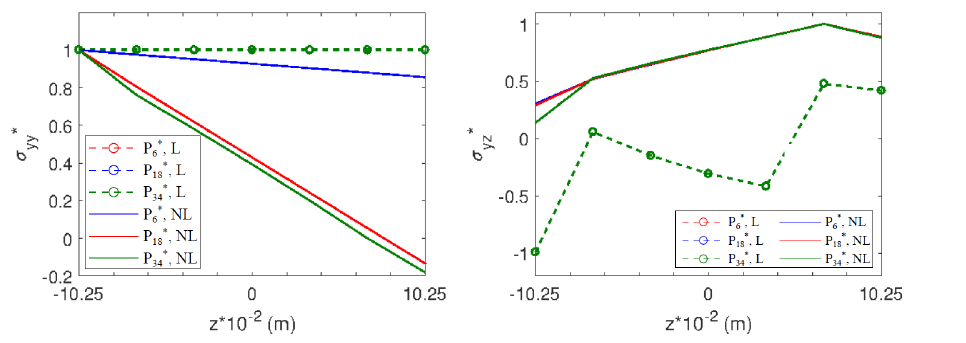
= − 3.3 − 4 , P ∗ = − 2.9 − 3 , 6 18 = σ yy / σ yy yy max